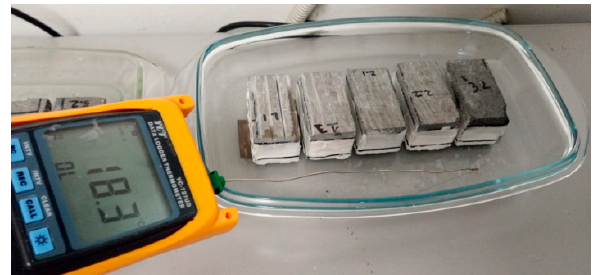
Figure 10 . Cementitious specimens during water sorptivity test . Figure 10. Cementitious specimens during water sorptivity test.